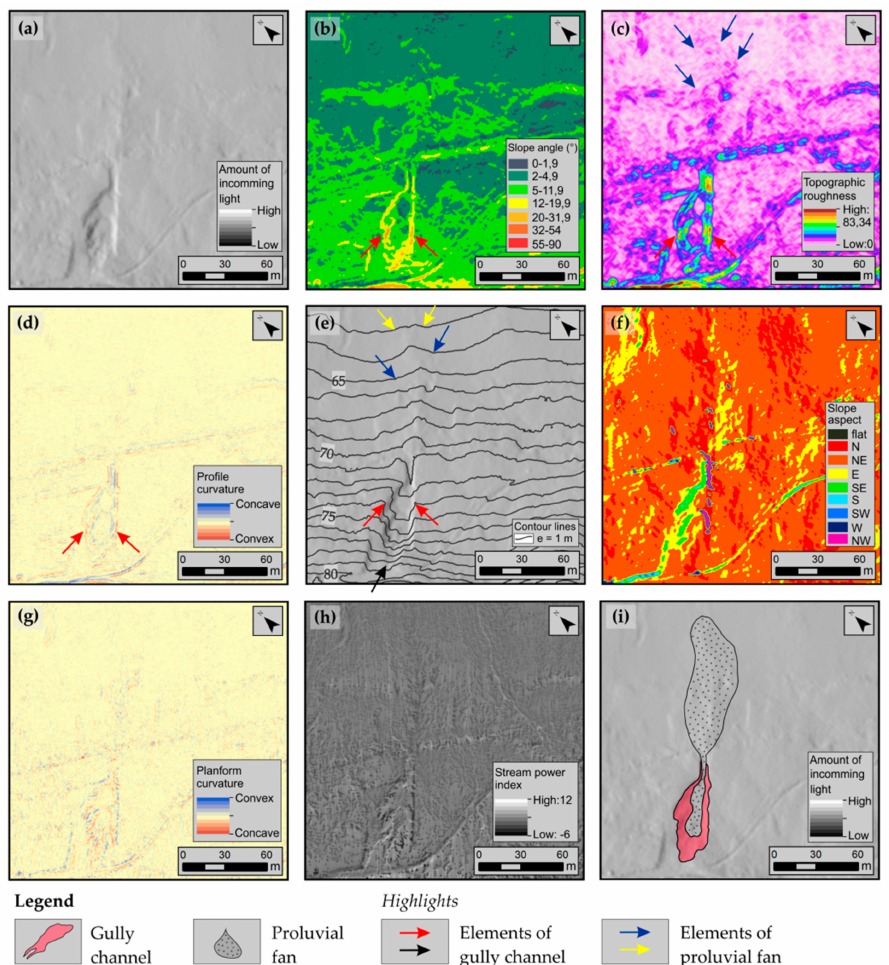
Figure 8. Visualization of topography of a small gully on HR LiDAR imagery: ( a ) the semi-transparent (50%) hillshade map 45 ◦ / 45 ◦ over the hillshade map 315 ◦ / 45 ◦ ; ( b ) the slope map; ( c ) the topographic roughness map; ( d ) the profile curvature map; ( e ) the contour line map over the hillshade map; ( f ) the aspect map; ( g ) the planform curvature map; and ( h ) the stream power index map. ( i ) The hillshade map with delineated polygons representing the gully channel and the proluvial